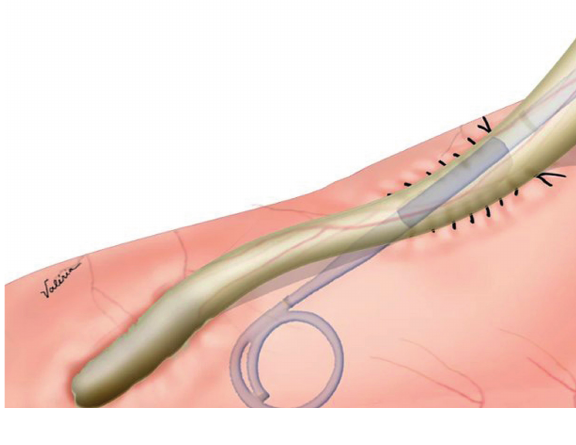
figure 3 - ureter-ileal bypass with 2J catheter.